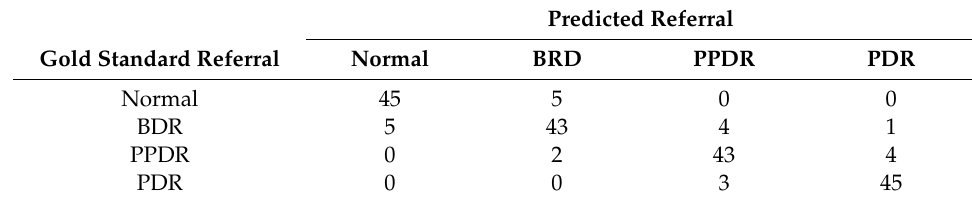
Table 1. Confusion matrix for 200 test subjects.